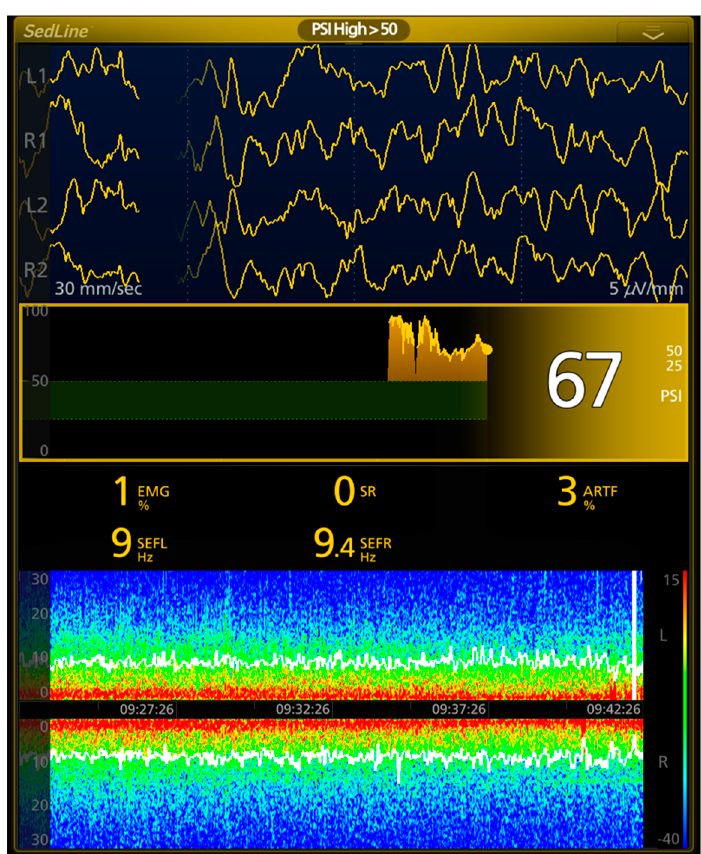
Figure 2. Spectrogram as a real-time clinically used method of EEG analysis with combination of raw EEG during computed tomography (CT) performed under general inhalant anesthesia in a horse with use of Root with Sedline ® , Masimo, Irvine, CA, USA.